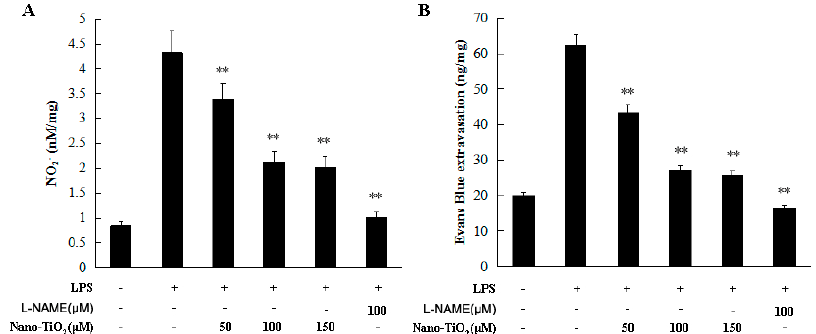
Figure 3. Effects of nano-TiO 2 on inhibiting vascular permeability. SD rats were injected with 50, 100, and 150 μ M nano-TiO 2 for 1 h prior to the addition of LPS stimulation, compared to 100 μ M L-NAME. ( A ) NO 2 − in the skin was detected using the Griess method; ( B ) Evans blue extravasation was used to evaluate the vascular permeability. Data were shown as means ± SD of three independent experiments. ** p < 0.01 against control group.